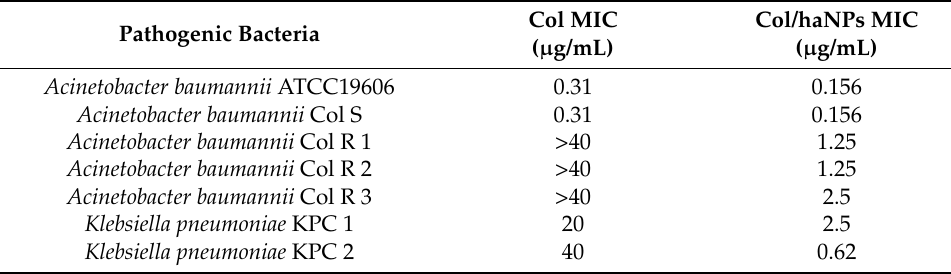
Table 4. Col and Col/haNPs MIC of bacteria strains analyzed. Pathogenic